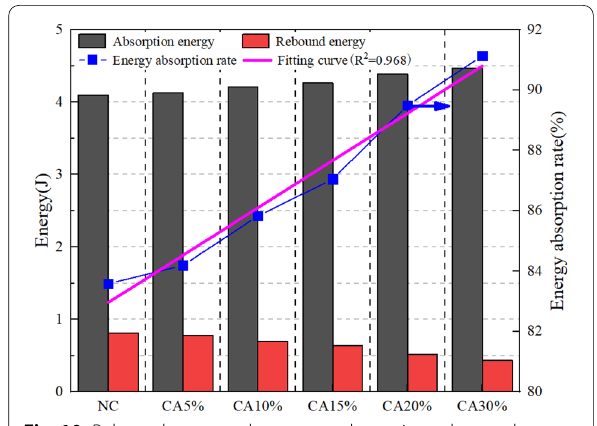
Fig. 10 Rebound energy value, energy absorption values and energy absorption